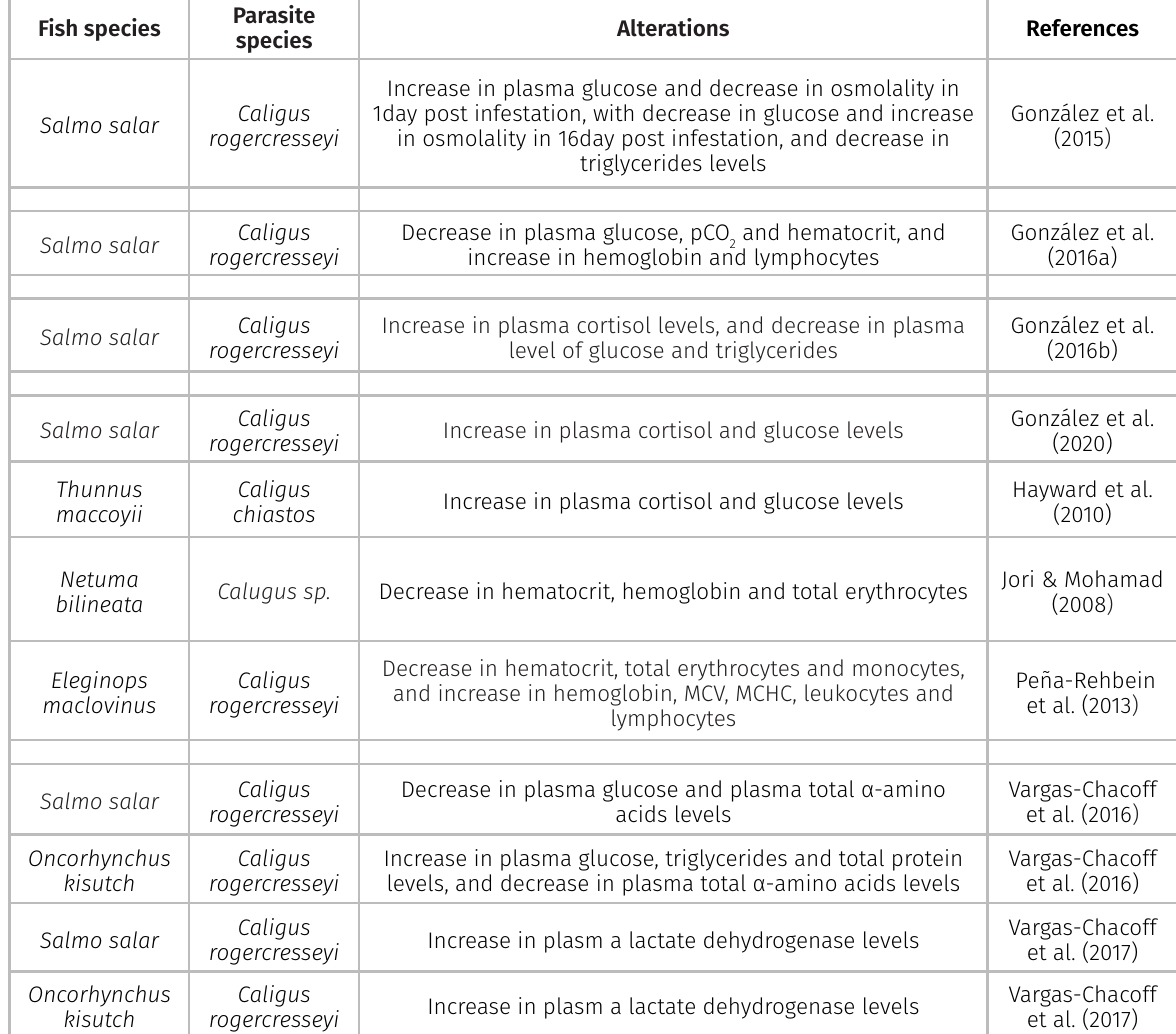
Table III. Hematological, biochemical, and immunological effects of Caligus spp. for different teleost